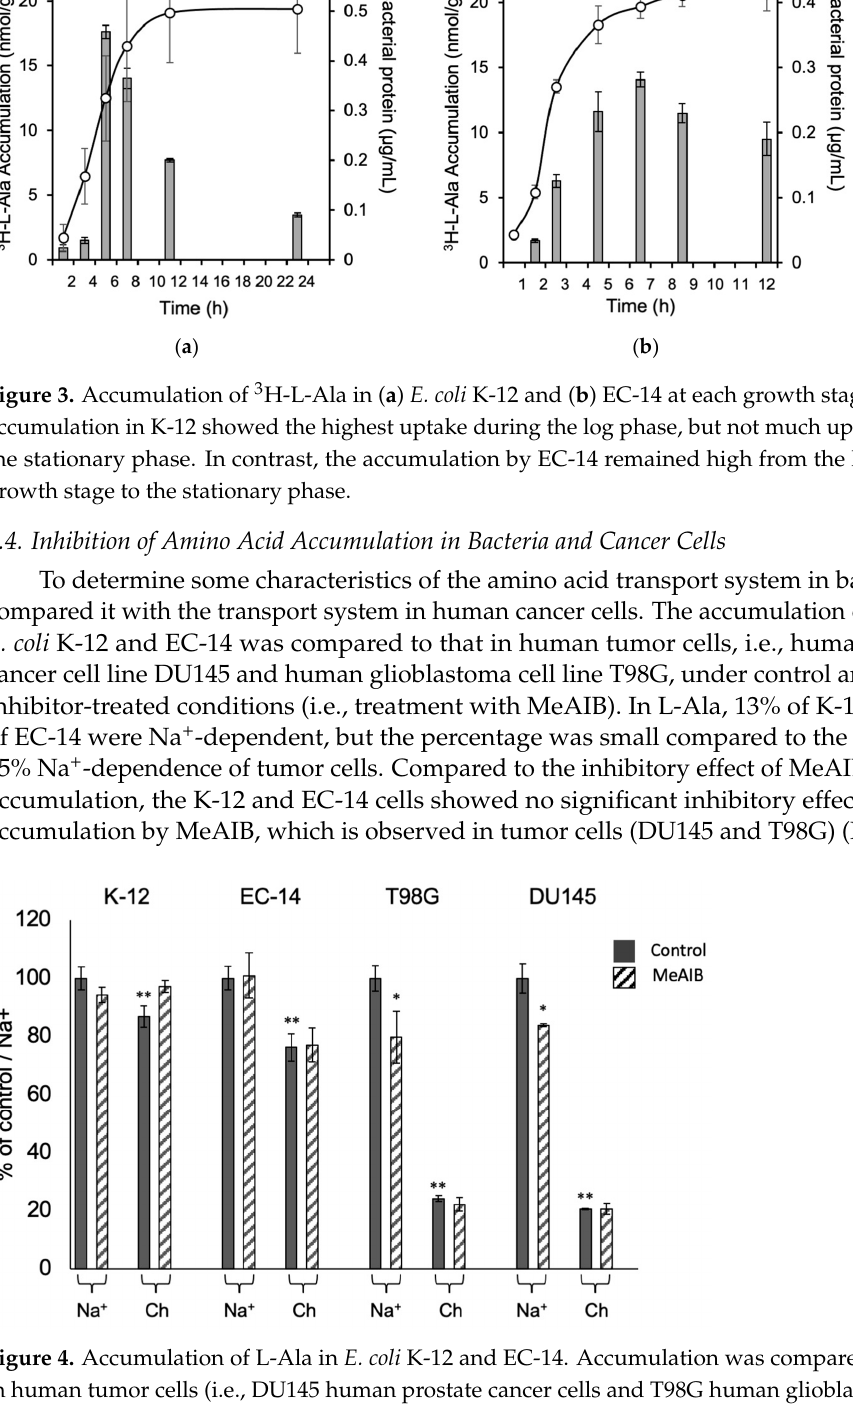
Figure 2. Accumulation of 3 H-L-Ala, 3 H-L-Met, 3 H-L-Glu, and 3 H-L-His in E. coli EC-14 at each growth stage. At 1 h, the accumulation of most of the amino acids was low. At 2 h and 4 h, 3 H-L-Ala and 3 H-L-Met accumulated more than the other amino acids. At 6, 8, and 12 h, 3 H-L-His showed the highest accumulation levels.